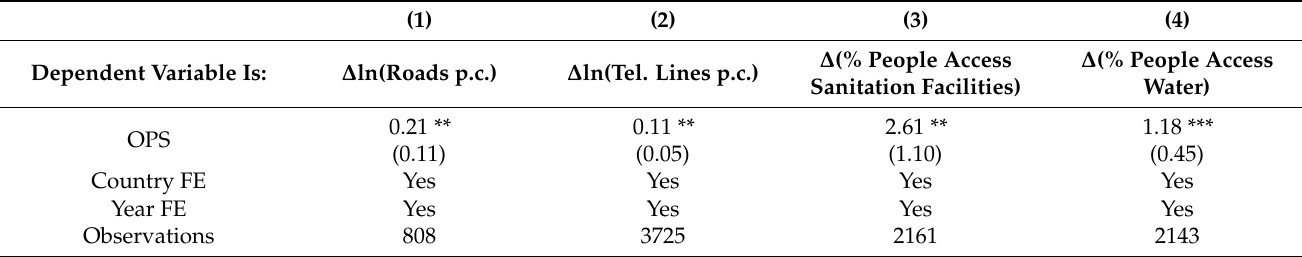
Table 4. Reduced form effects of OPS on infrastructure.